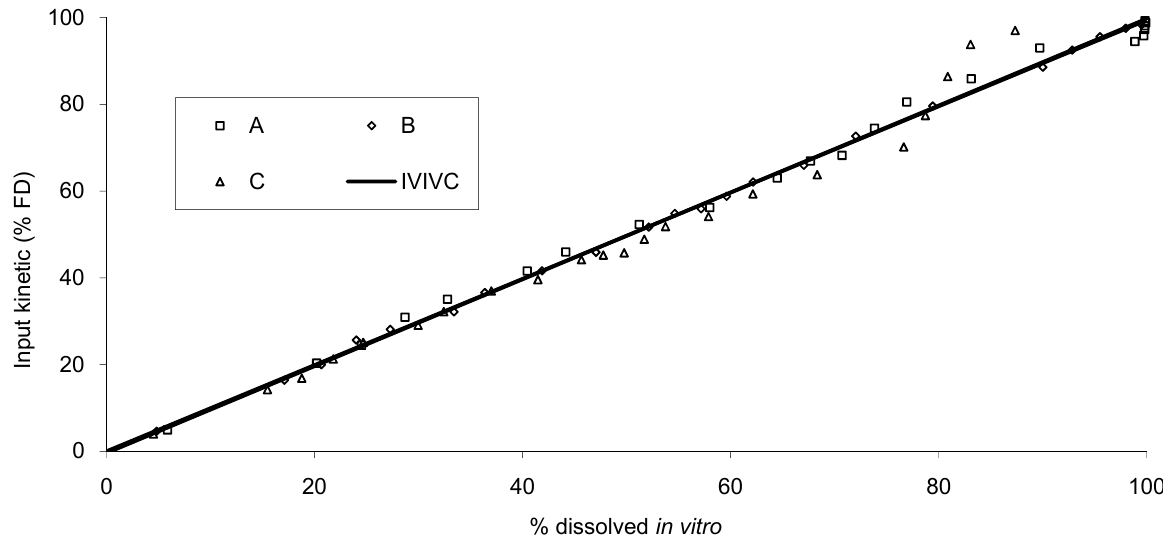
Figure 7. IVIVC established on all formulations using a non-linear time scaling common to all formulations.